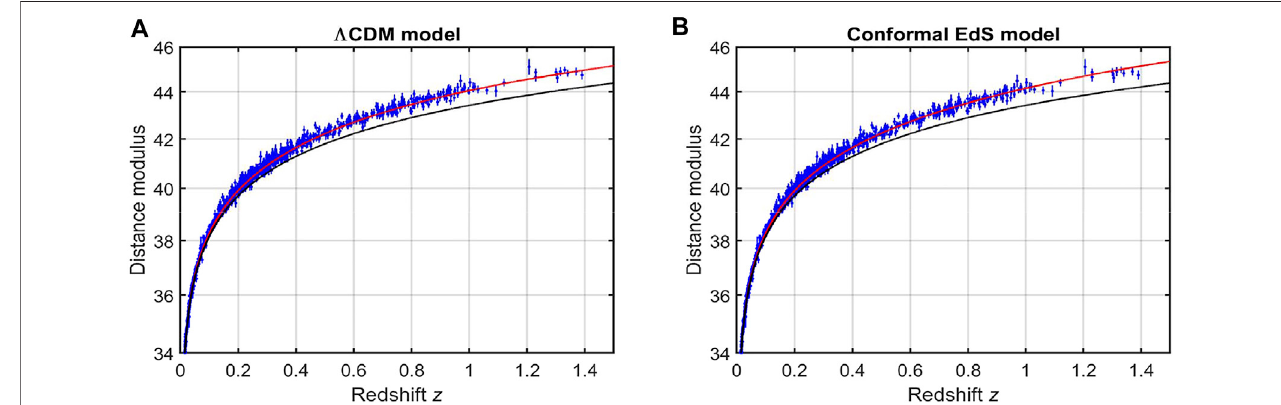
FIGURE 1 | The Hubble diagram with Type Ia supernovae observations. Blue dots show measurements of the SNe Pantheon compilation [45, 46]. The red line in (A) showsthe Λ CDMmodeldescribedby Eq.30 with Ω m =0.3and Ω Λ =0.7.Theredlinein (B) showstheconformalEdSmodeldescribedby Eq.32 with Ω m =1.2and − 0.2. The black line in (A,B) shows the standard EdS model described by Eq. 31 with Ω Ω k = obtained from observations of the SNe Ia data with a red giant calibration [55].